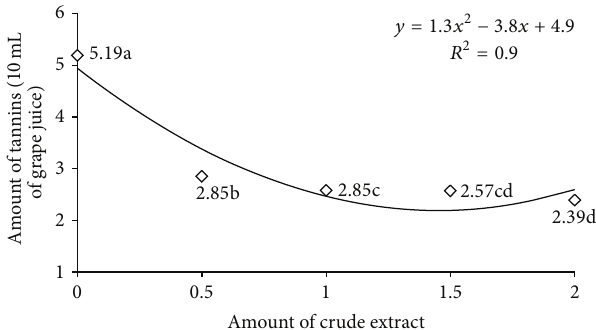
Figure5:Effectofdifferentvolumesoftannaseinthedegradationof tanninspresentingrapejuiceafter120minutesofincubation.Values on 𝑌 -axis represent the amount of tannins in the